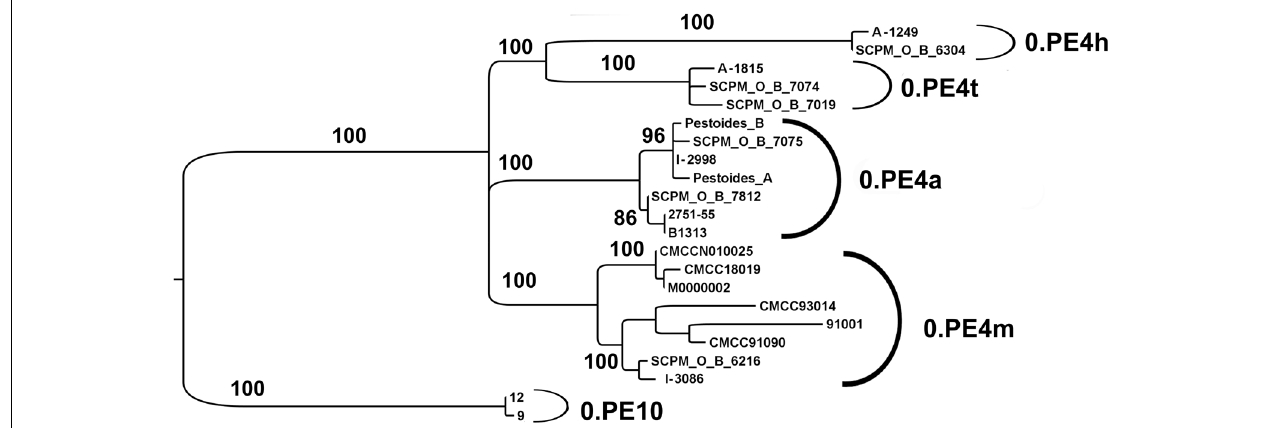
FIGURE 4 | Phylogenetic analysis of Y. pestis strains of 0.PE4 branch from natural plague foci of RF, Tadzhikistan, Kyrgyzstan, Mongolia, and China countries (fragment of the global phylogeny dendrogram of Y. pestis, shown in Figure 2 ). Maximum likelihood tree, PHYML 3.1 software program, HKY85 model and 500 bootstrap replications. Strains I-2998, 2751, and B1313 are from the Gorno-Altay high-mountain focus (36); A-1249 from Hissar high-mountain focus (34); A-1815 from Talas high-mountain focus (40); I-3086 from Mongolia; other strains are from NCBI GenBank: SCPM_O_B_7075, SCPM_O_B_7812 from Gorno-Altay